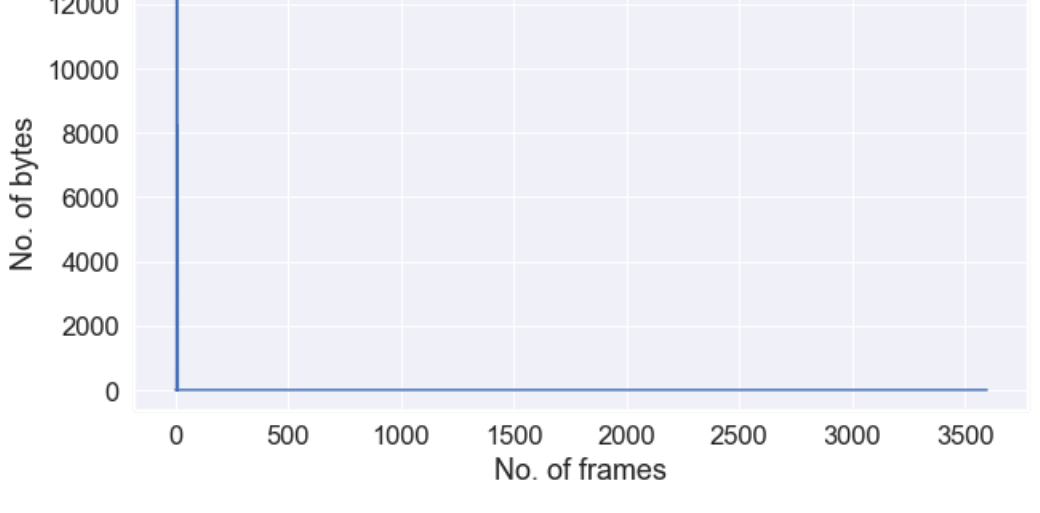
Figure 22a. Disk reads in S2.3.